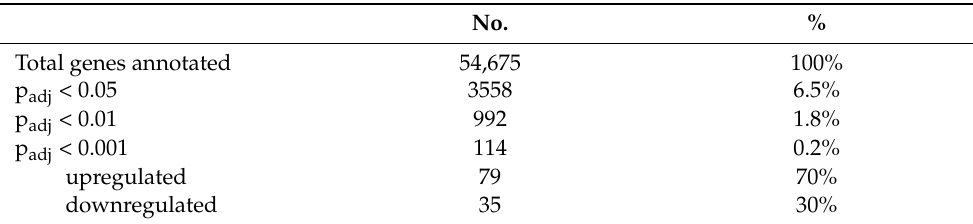
Table 1. Results of the GEO2R analysis of the GSE8056 dataset. The groups for control (no burn) and the pooled burn samples 3 days after the burn wounds were